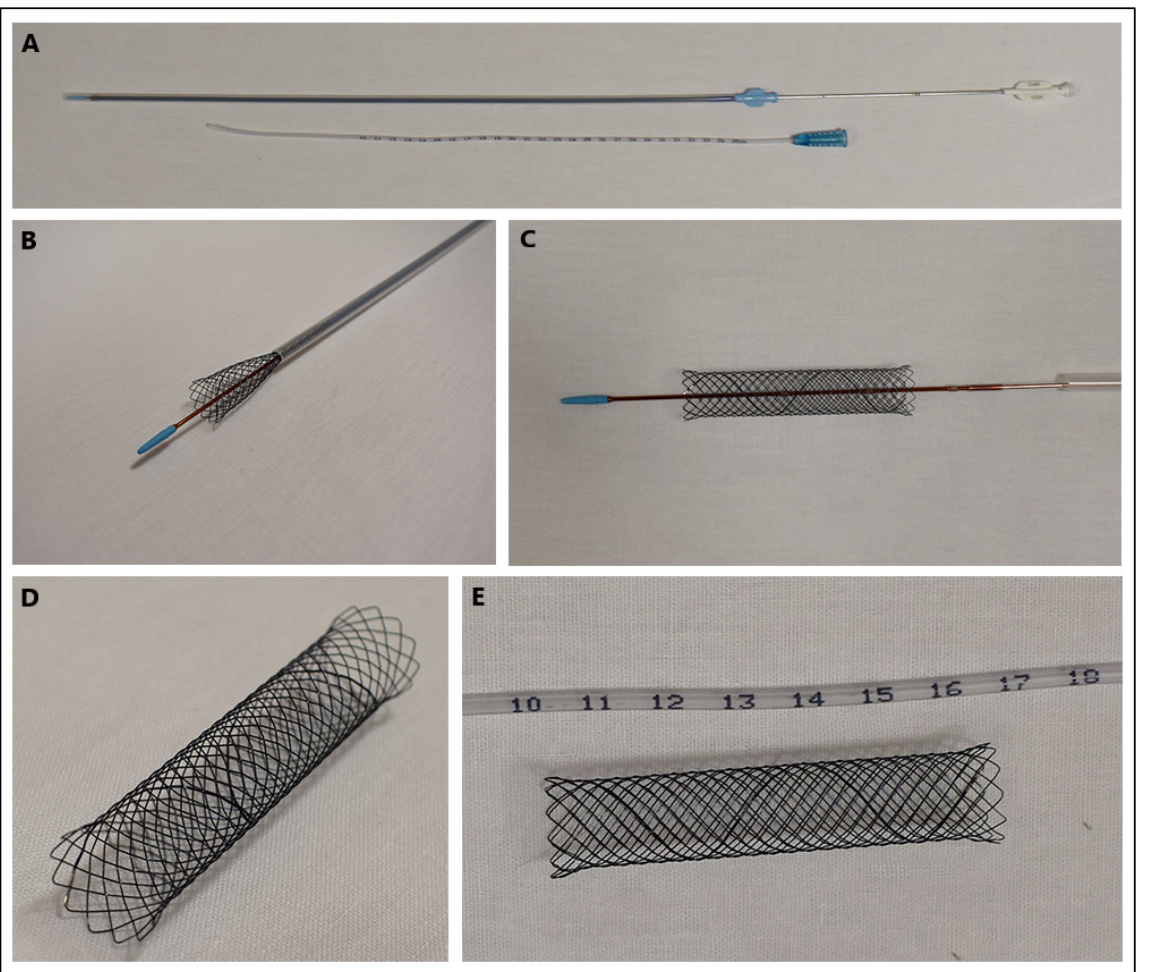
Figure 2. ( A ) Tracheal stenting kit containing a nitinol stent with a cross-braid and a measure to assess the tracheal length. ( B ) View of the initial stent deployment process. ( C , D , E ) Different views of the fully expanded stent. The photographs come from the private archives of Dr Dariusz Jagielski.